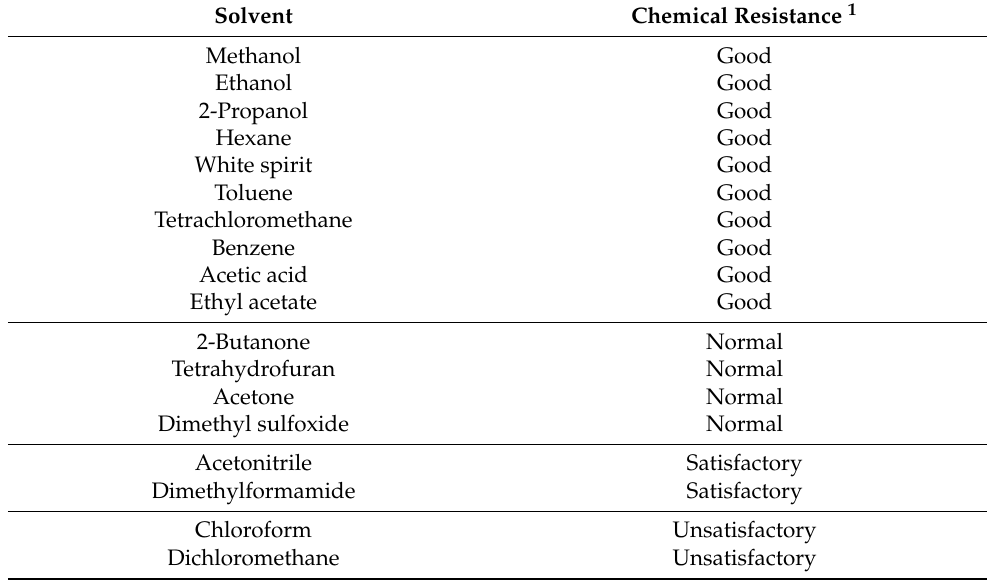
Table 1. The chemical resistance of OSTE-AS to organic solvents at room temperature.